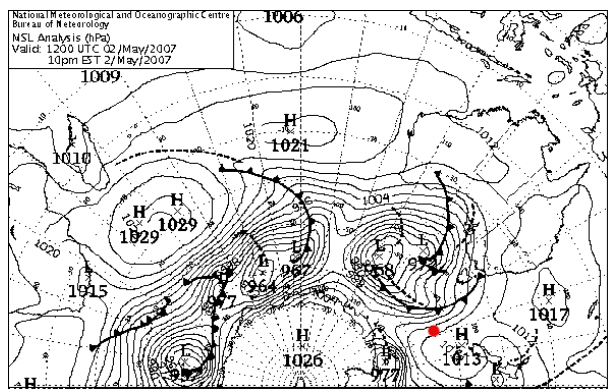
Figure 1. MSLP chart for 2 May 2007 at 12Z. The approximate location of Macquarie Island is shown by the red dot. (Source: Aus- tralian Bureau of